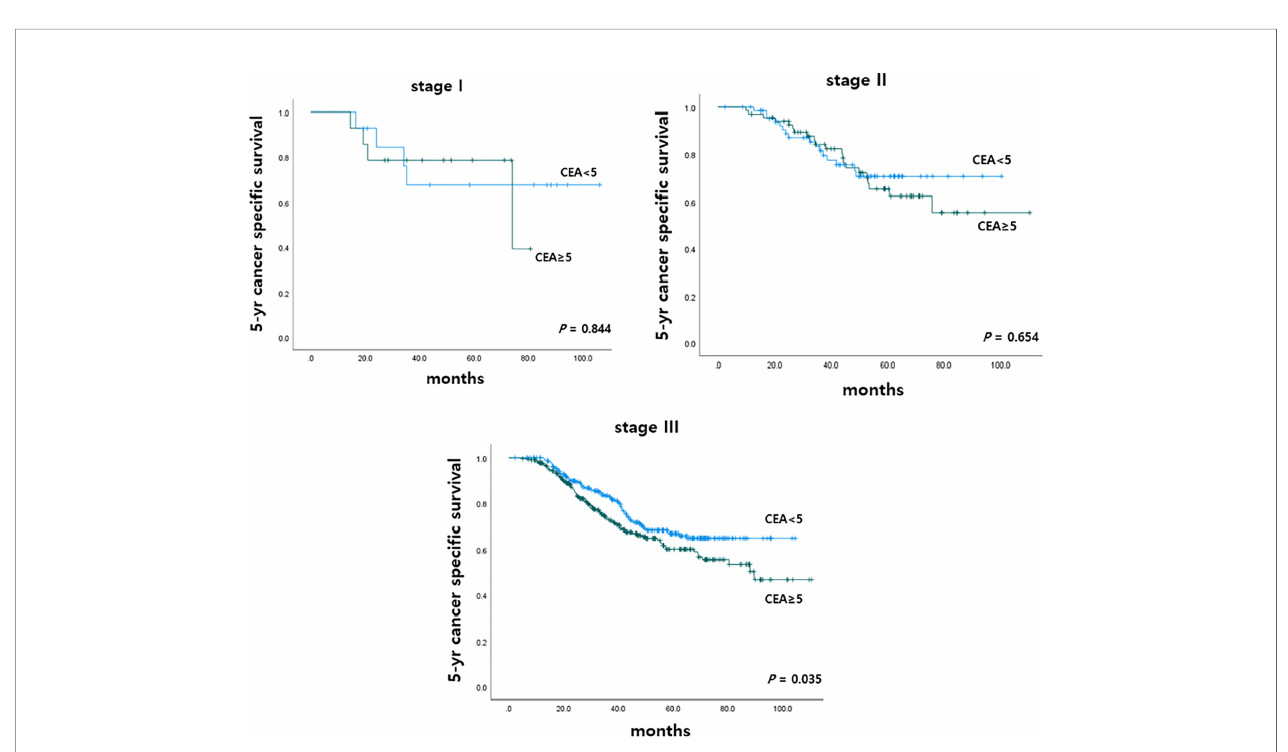
FIGURE 4 | Five-year cancer speci fi c survival according to CEA level at the time of recurrence in matched patients.